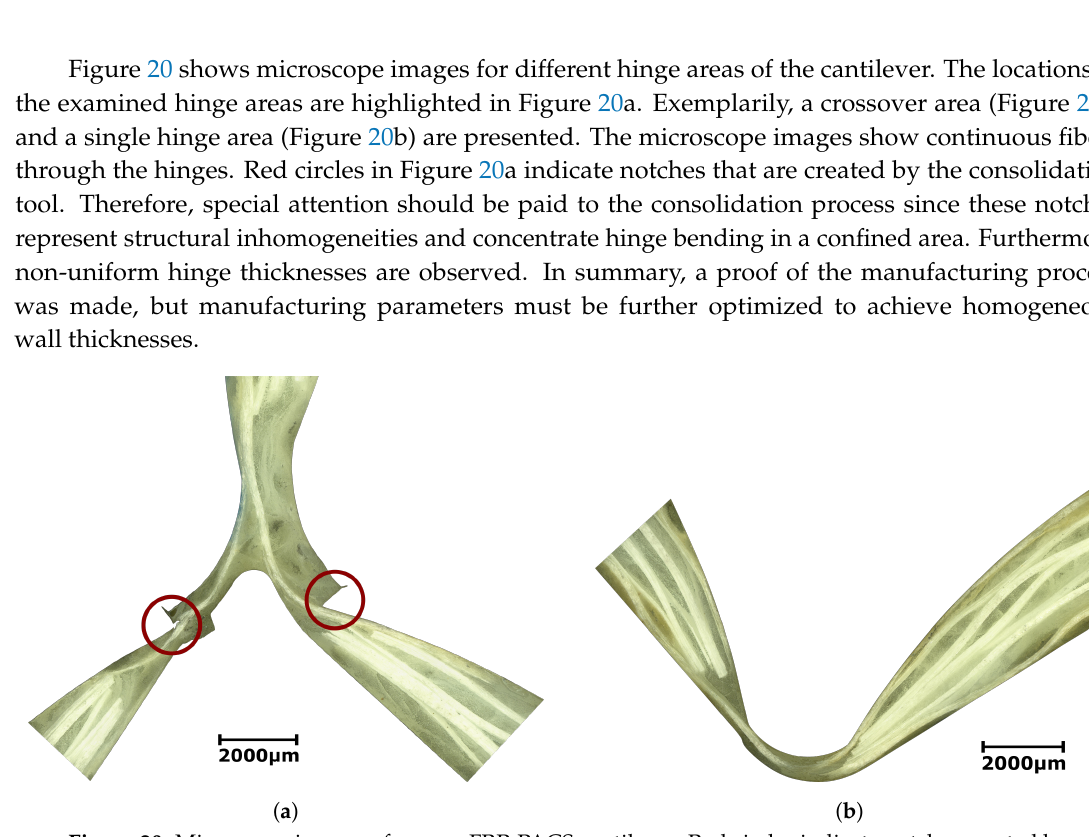
Figure 20. Microscope images of woven FRP-PACS cantilever. Red circles indicate notches created by the consolidation tool: ( a ) Crossover area. ( b ) Single hinge